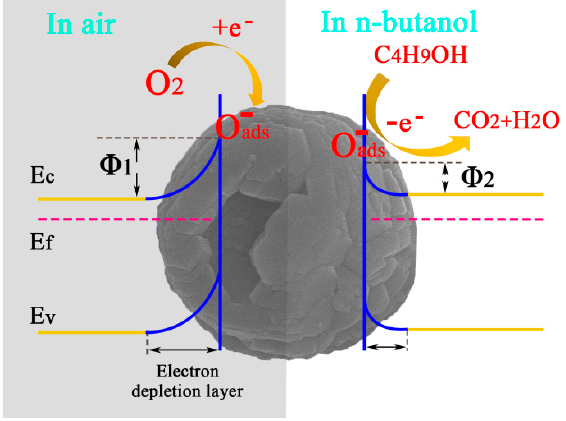
Figure 8. Schematic illustration of the sensing mechanism and the energy band diagram.